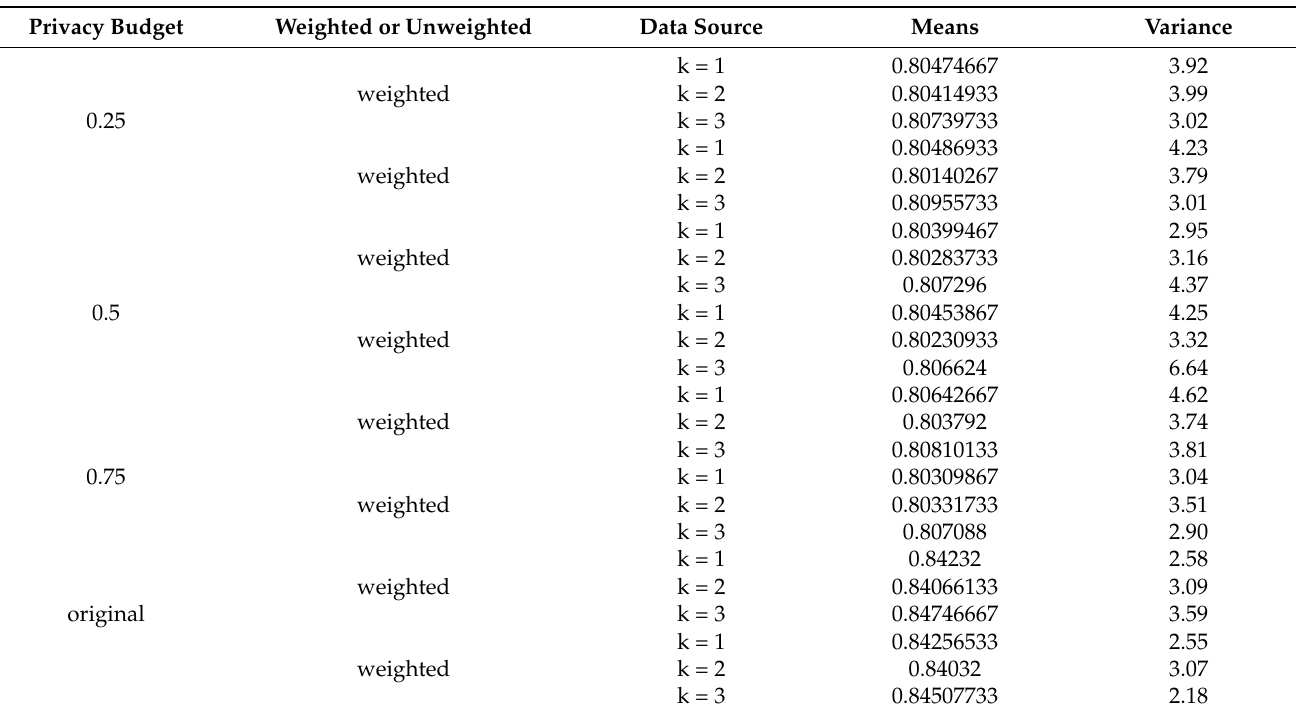
Table 4. The performance of the initial global model H 1 over the t 2 period of the federated aver- age